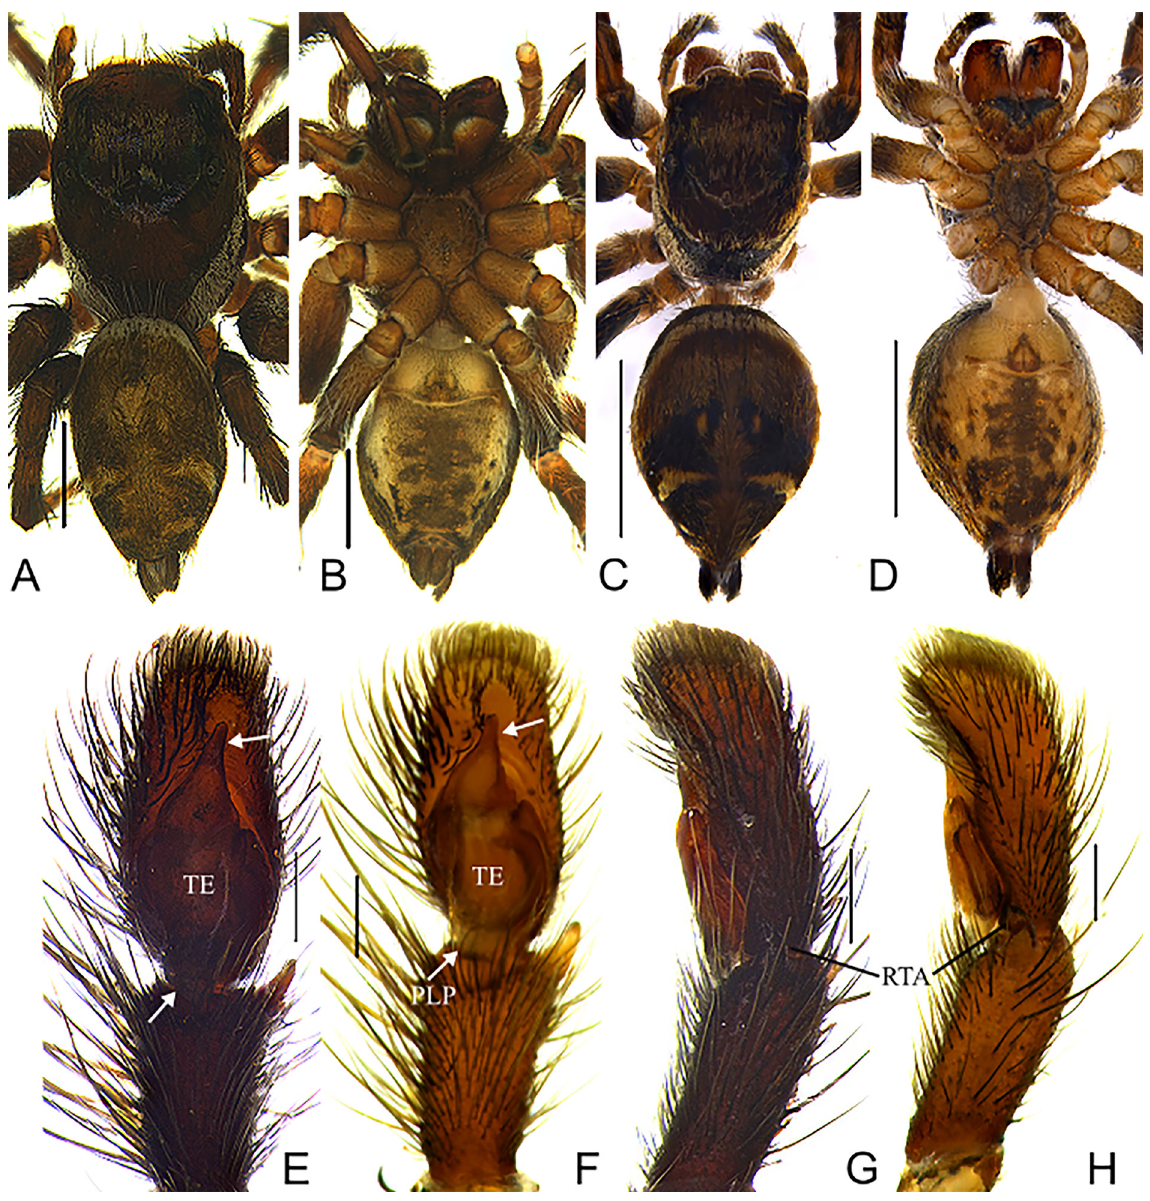
Fig. 11. Carrhotus silanthi Caleb, 2020. A–B . Male habitus. A . Dorsal view. B . Ventral view. C–D . Female habitus. C . Dorsal view. D . Ventral view. E–H . Palp. E–F . Ventral view; the arrows showing the embolus tip directed in clockwise (11E) or directed in apical (11F). G–H . Retrolateral view. Abbreviations: PLP = posterior lateral protrusion; RTA = retrolateral tibial apophysis; TE = tegulum. Scale bars: A–D = 2 mm; E–H = 0.2